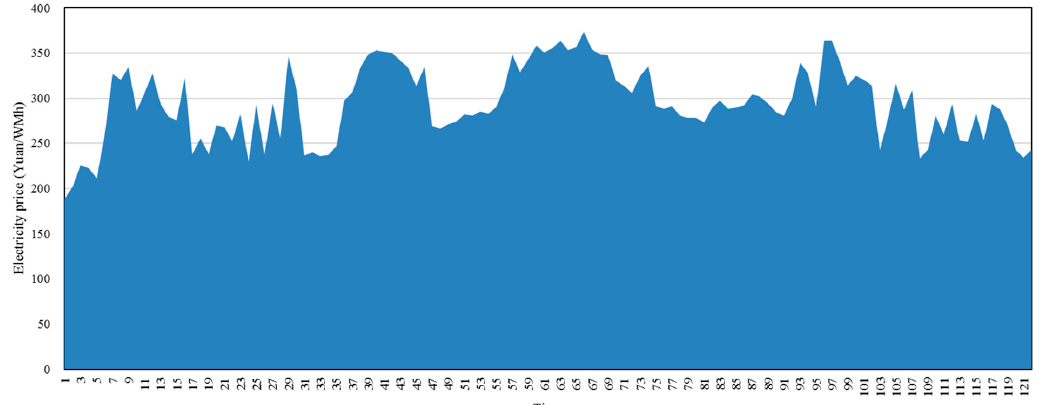
Figure 4. The iterative RMSE trends of FOA-LSSVM model for deterministic term, periodic term, and stochastic term.